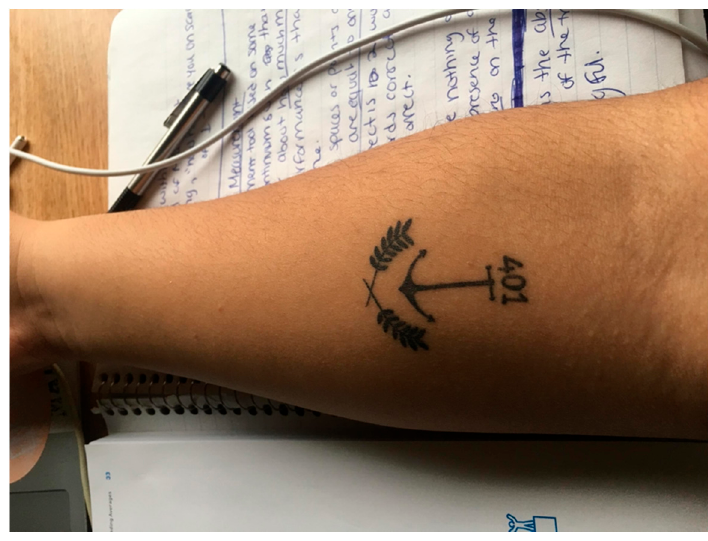
Figure 5. Esther’s tattoo, matching with her brother. Other respondents had easier experiences negotiating their tattoos with their religious heritage. Maia (Hindu, 19) found it easier to rely on her mother’s side of the family, who were “much more progressive Indian” than those on her father’s side, who were “much more strict Indian”. She chose the location of her tattoo carefully so that “when you wear Indian outfits, its’ cropped, all the tops are cropped and I did not want my dad’s side of the family to necessarily know that I had a tattoo, even though it is for religious reasons” (see Figure